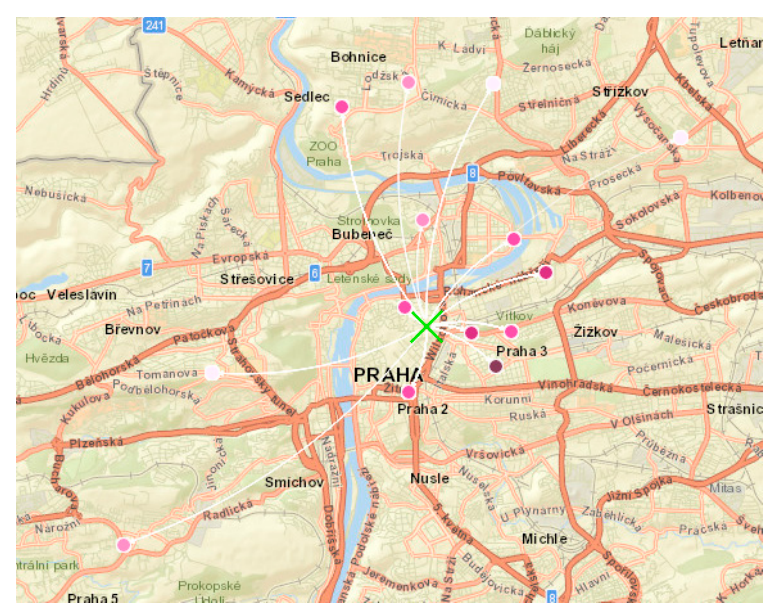
Figure A1. This image shows the geographical location of all 14 gateways that received a message from the device during the experiment. The color range of the dots corresponds to the frequency of received messages. The green cross shows the place from which it was broadcast.